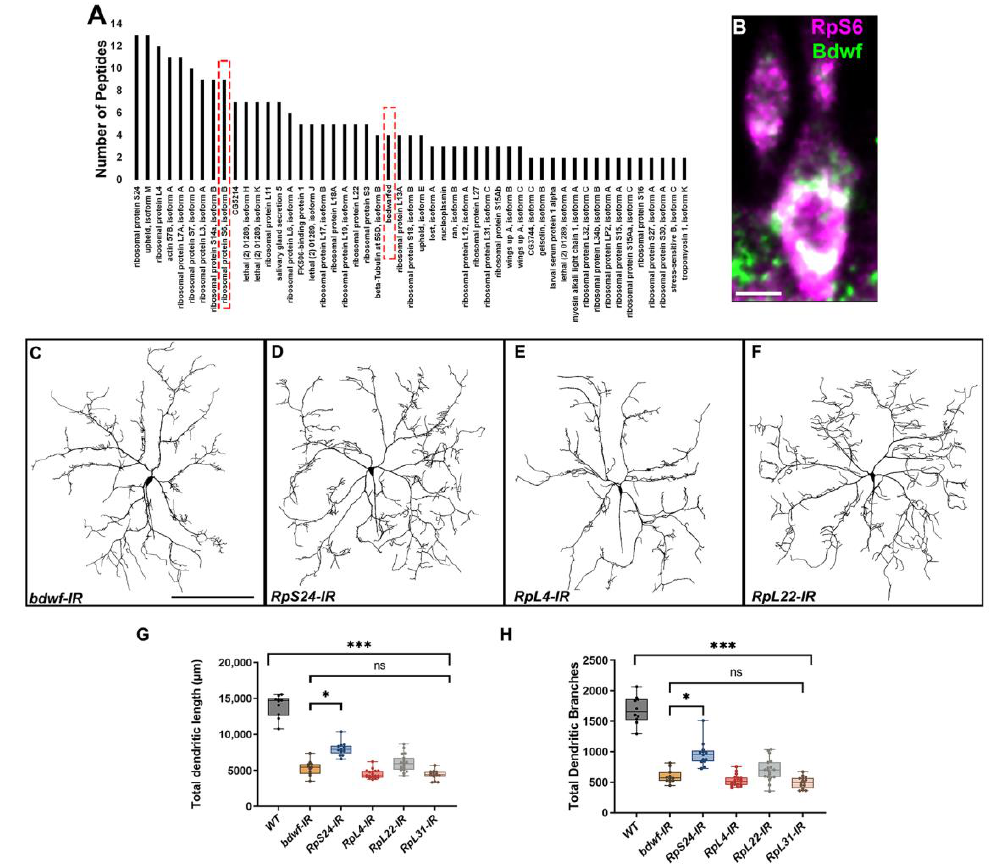
Figure 6. Bdwf interacts and colocalizes with ribosomal proteins. ( A ) Bdwf-interacting proteins identified from MS analysis of affinity-purified Bdwf protein using our rabbit anti-Bdwf polyclonal antibody from homogenized third-instar larvae expressing UAS-bdwf-FLAG-HA protein driven by GAL4 Act5C driver. Bdwf and ribosomal protein S6 are marked by a red dashed box. ( B ) Bdwf co-localizes with the 40 S ribosomal protein S6 to a high degree in md neurons. Knockdown of ribosomal proteins leads to a significant reduction in the TDL ( G ) and TDB ( H ) compared to the control. Except for RpS24-IR , knockdown of all the ribosomal proteins phenocopied bdwf knockdown with a high degree of penetrance. Representative images of bdwf-IR , RpS24-IR , RpL4-IR , and RpL22-IR ( C – F ). Scale bar, 10 µm ( B ), 200 µm ( C – F ). ( G , H ) Quantification of TDL and TDB in CIV ddaC neurons. * p ≤ 0.05, *** p ≤ 0.01, n.s.=not significant. n = 8 for WT, n = 11 for bdwf-IR , n = 13 for RpS24-IR , n = 19 for RpL4-IR , n = 19 for RpL22-IR , n = 15 for RpL31-IR . Genotypes: GAL4 477 ,UAS – mCD8::GFP/+; GAL4 ppk1.9 , UAS – mCD8::GFP/+ , or GAL4 477 , UAS – -mCD8::GFP/+;GAL4 ppk1.9 , UAS – mCD8::GFP/UAS – bdwf – IR , or GAL4 477 ,UAS